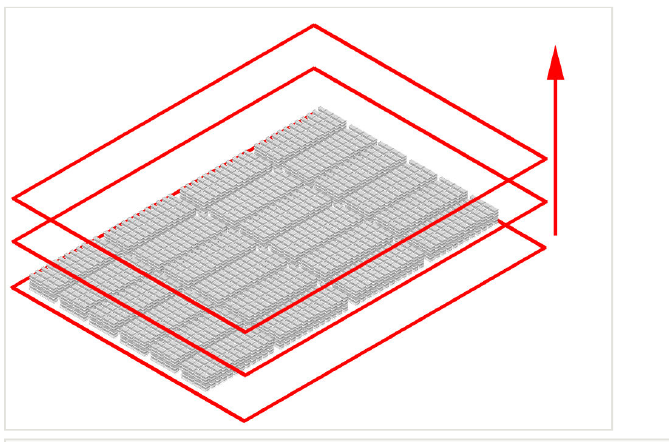
Concept of upscaling the production of crops for large-scale food production. The red box indicates 1 fl oor. By upscaling upwards, the same amount of land area occupied by a single growhouse will enable an exponential increase in